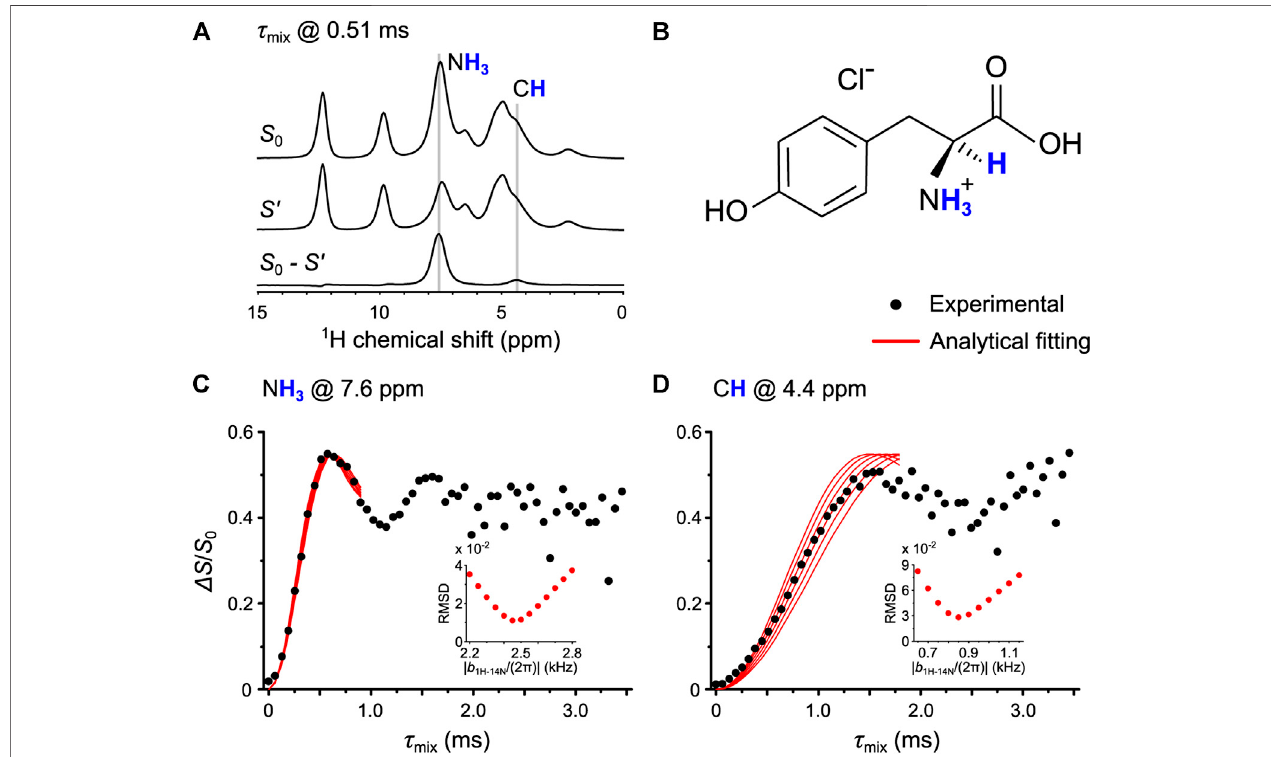
FIGURE7|(A) The1D 1 Hspinecho( S ′ ),andthedifference( S – S ′ )spectraofTyr.Theformertwowereextractedfrom 1 H- 14 NOT-REDORwith 0 ),thedephased( S 0 (B) The molecular structure of Tyr where N H 3 and C H are presented. ( C,D) The fi tting of τ mix of 0.51 ms, whereas the latter is calculated from the former two. experimental 1 H- 14 N OT-REDOR fraction curves (black circles) by the universal curves (red lines) for N H 3 at 7.6 ppm in (C) and C H at 4.4 ppm in (D) . The fi tting parameter f for universal curves is 0.82. The RMSD analyses (inset) were calculated for the best fi tting 1 H- 14 N dipolar couplings.